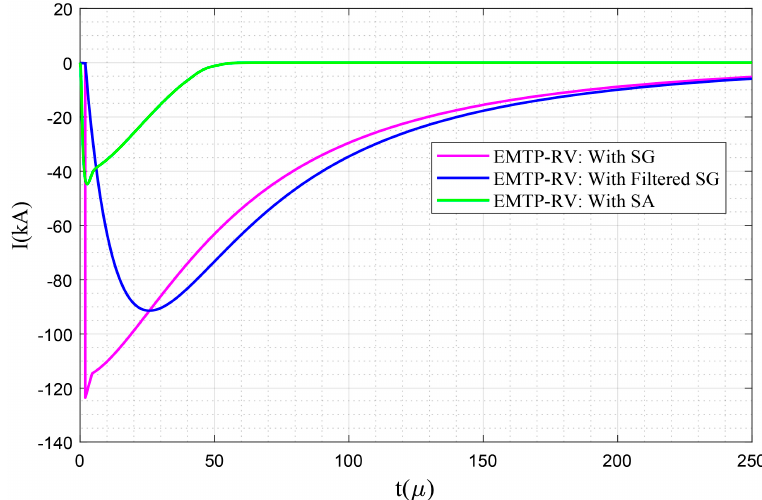
Figure 25. Comparison of the current flows before the connection points of the spark gap (SG) and surge arrester (SA).